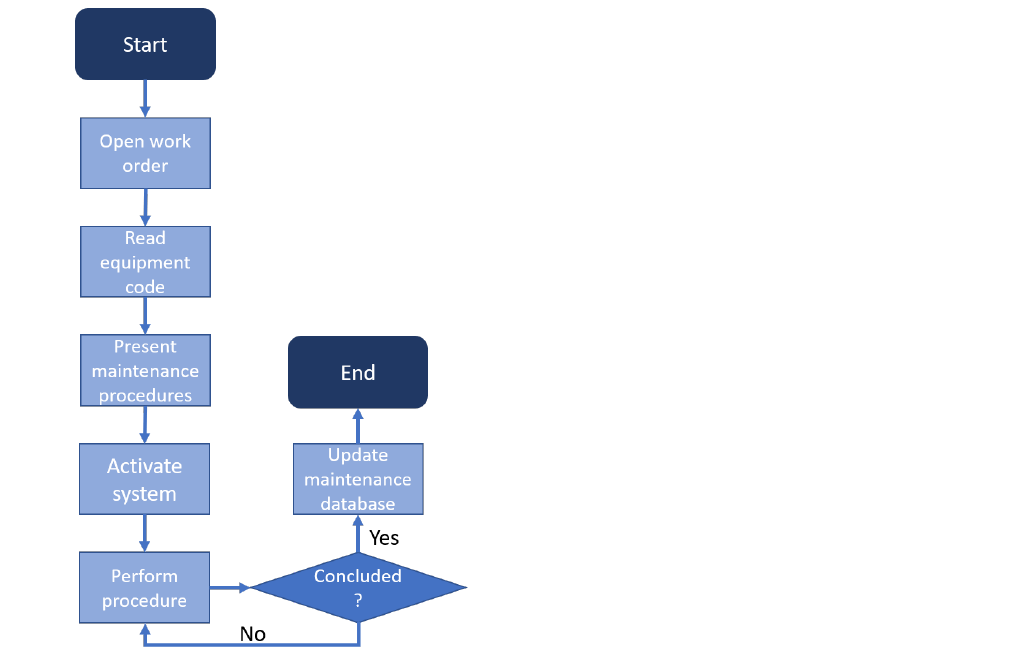
Figure 1. Flowchart showing the sequence of actions necessary to process a given work order, to perform maintenance tasks. The task assistant guides the maintenance technician through the steps